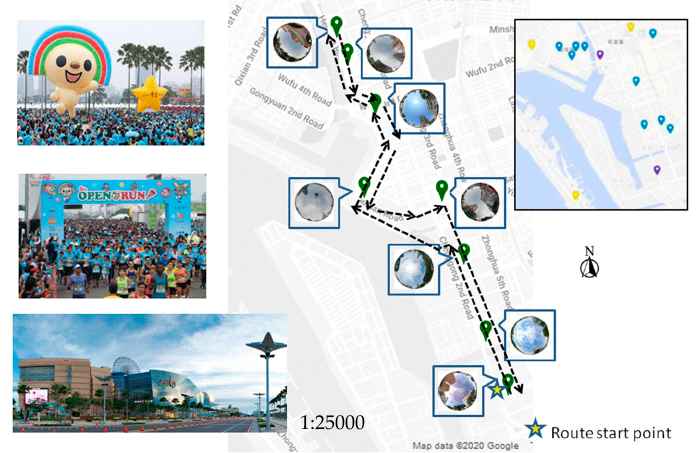
Figure 10. Winter running event route, activity photos, and fisheye photos.